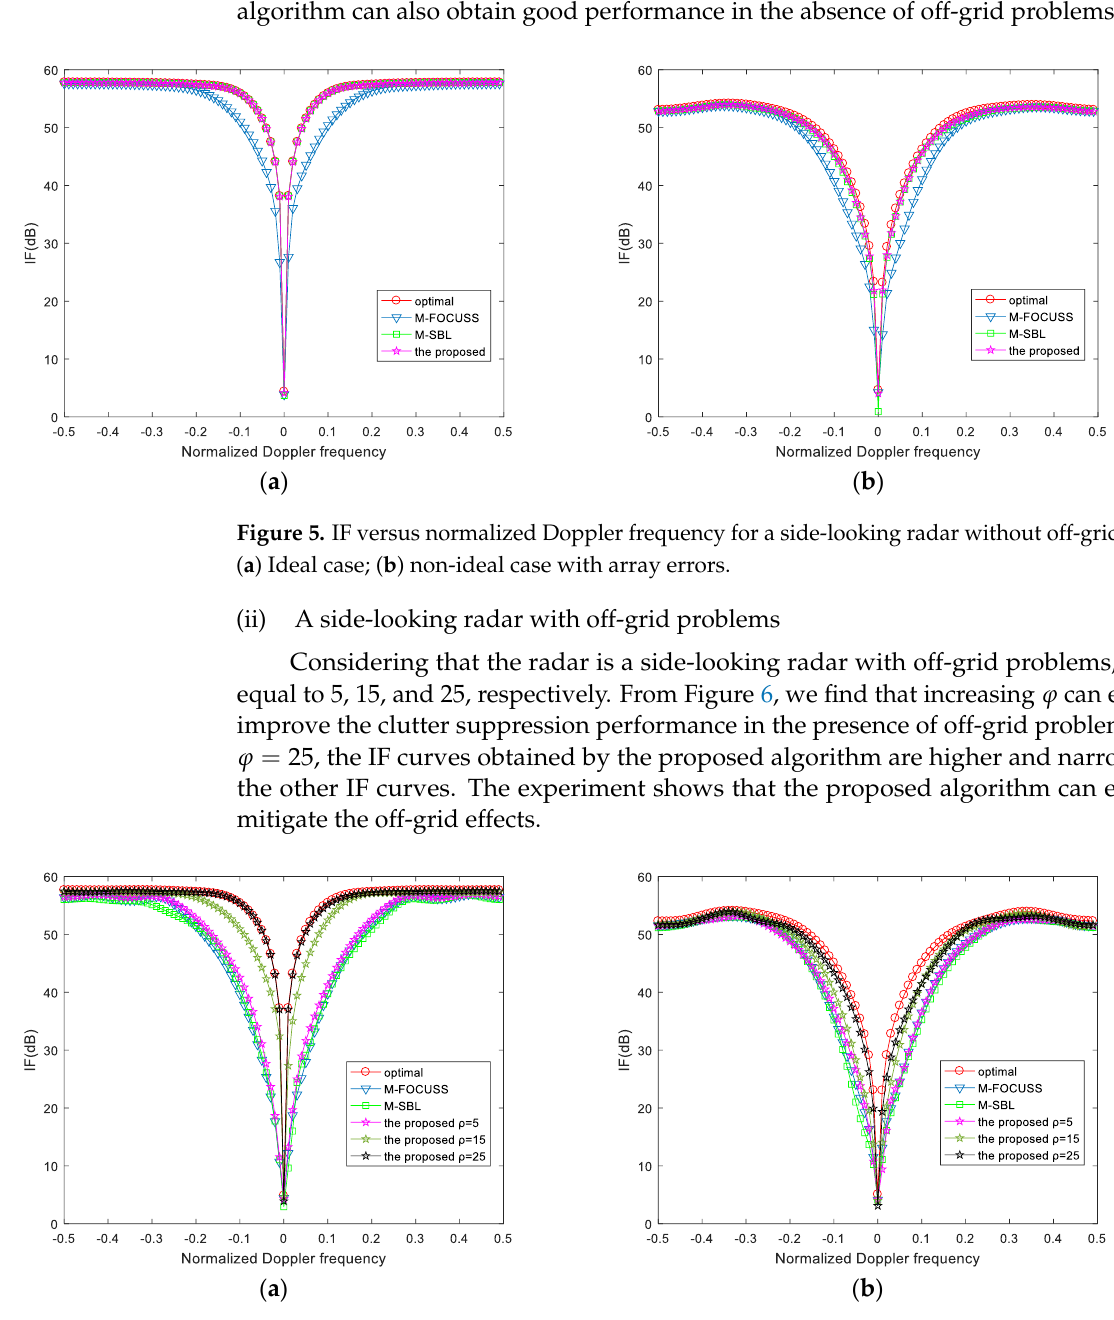
Figure 6. IF versus normalized Doppler frequency for a side-looking radar with off-grid problems. ( a ) Ideal case; ( b ) non-ideal case with array errors. (iii) A forward-looking